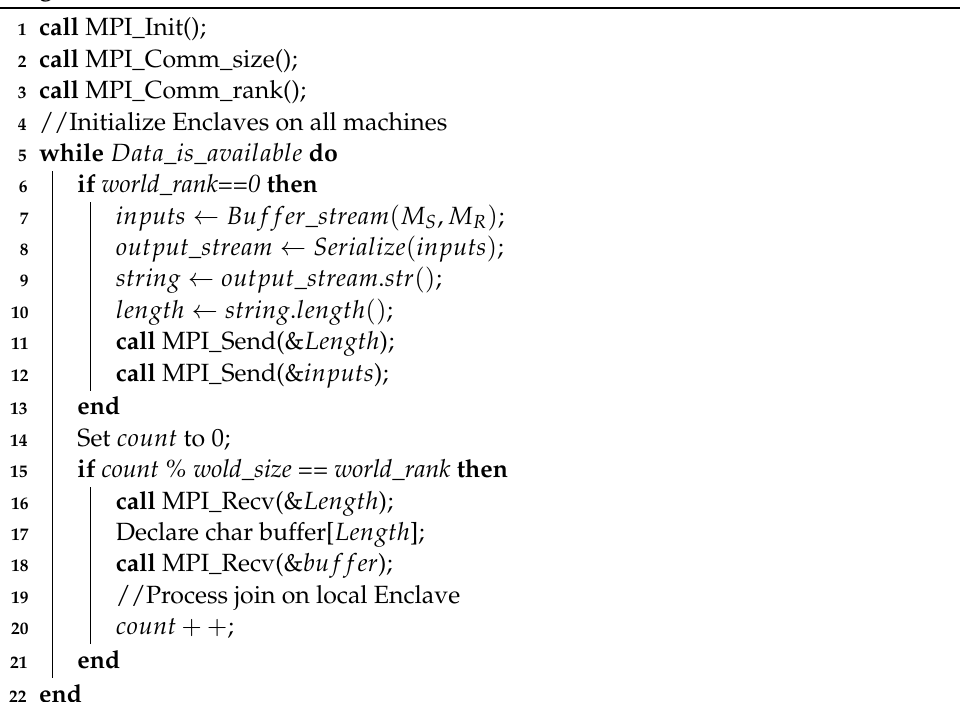
Algorithm 1: Pseudo-code for an MPI Join